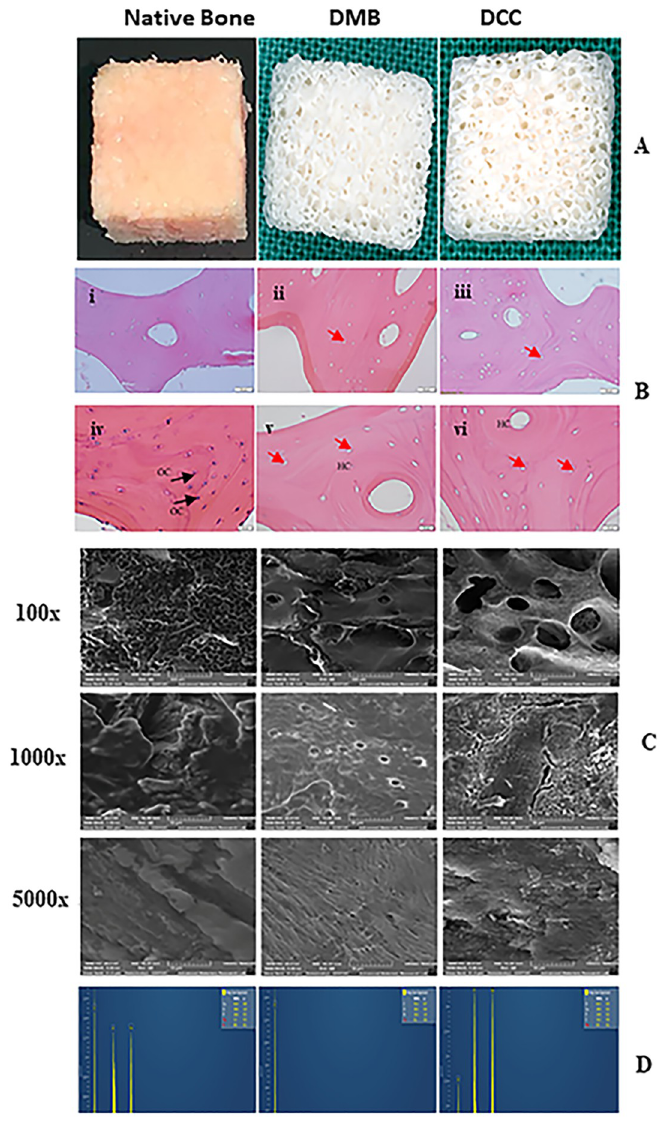
Fig 2. (A). Gross appearance of DMB and DCC scaffolds. The DMB and DCC scaffolds appeared as a clean white sponge, with a gross porous structure compared to untreated native control bone. (B). Hematoxylin and Eosin staining images of bone scaffolds. (i, iv) Control native bone; (ii, v) DMB scaffold; and (iii, vi) DCC scaffold. Prior to sectioning, the DMB and DCC samples were both decalcified using the Shannon TBD-1 Decalcifier. Staining with Hematoxylin and Eosin showed intact osteocytes nuclei in control native bone (black arrows) while nuclei were largely removed from the DMB scaffold cells and absent in the DCC scaffold, resulting in empty lacunae with no visibly-stained nucleus within the lacunae (red arrow). HC- Haversian canal, OC-osteocyte. The scale bar is 50 μ m (upper panel) and 20 μ m (bottom panel). (C). Representative SEM images of DMB and DCC scaffolds compared to native control. Magnification at 100x, 1000x and 5000x is indicated. (D). EDS surface analysis of the scaffolds. The EDS surface analysis technique used a representative spectrographic analysis showing the surface chemical elements detected in DMB and DCC scaffolds compared to native